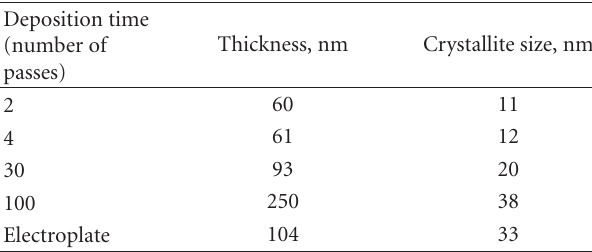
Table 1: Number of passes, thickness, and crystallite